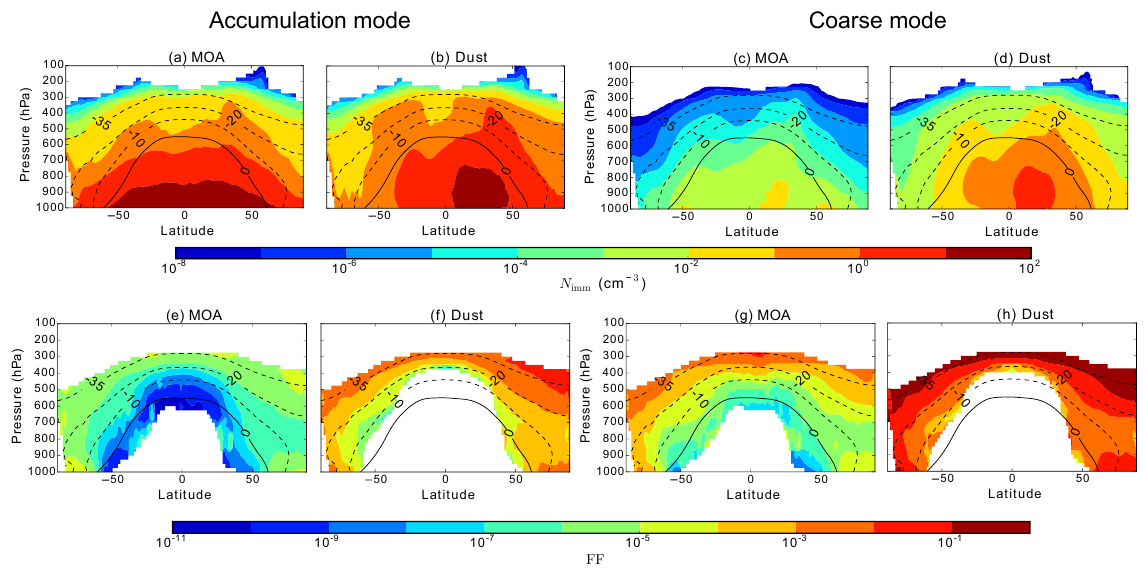
Figure 7. Multi-annual, zonal mean number of accumulation-mode (a, b, e, f) and coarse-mode (c, d, g, h) particles immersed in droplets ( N imm ; a–d ) and the frozen fraction (FF; e–h ) for MOA ( a , e and c , g ) and dust aerosol ( b , f and d , h ), from the free “MOA” simulation with the Wilson et al. (2015) freezing parameterisation for MOA and CNT for dust. Contour lines denote isotherms in the mixed-phase temperature range. FF is only plotted where the freezing occurs more frequently than 0.1% of the